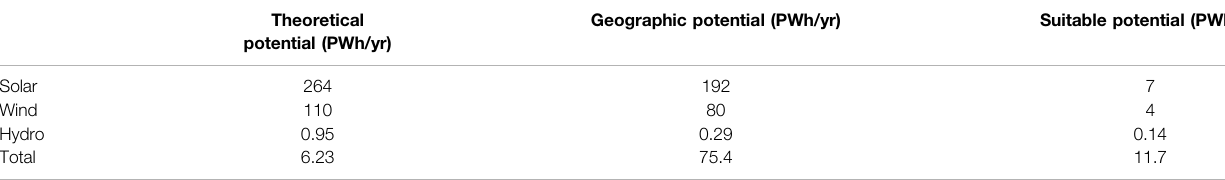
TABLE 1 | Ethiopian suitable renewable energy